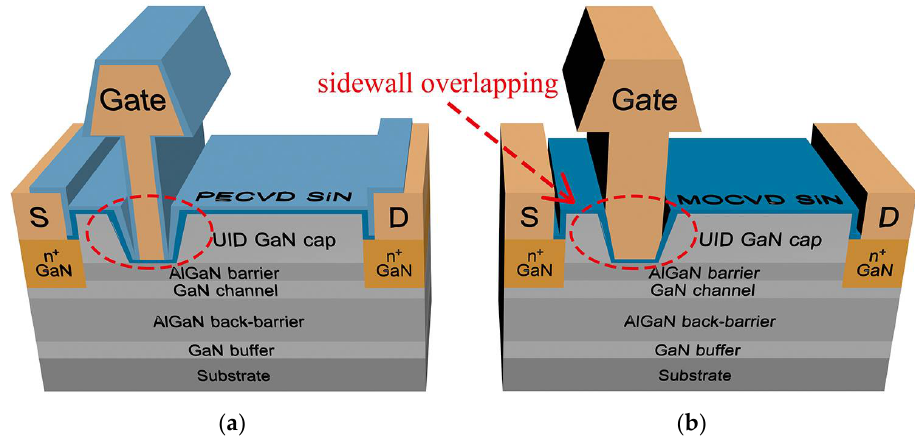
Figure 10. ( a ) DC and pulsed I DS –V DS measurements of the NPDR MIS-HEMT, fabricated by Wie- necke et al. in 2016. Adapted with permission from Ref. [55]. Copyright 2016 by IEEE. ( b ) DC and pulsed I DS –V DS measurements and ( c ) small-signal RF performance of the NPDR MIS-HEMT with gate-sidewall overlapping, fabricated by Steven et al. in 2017. Adapted with permission from Ref.